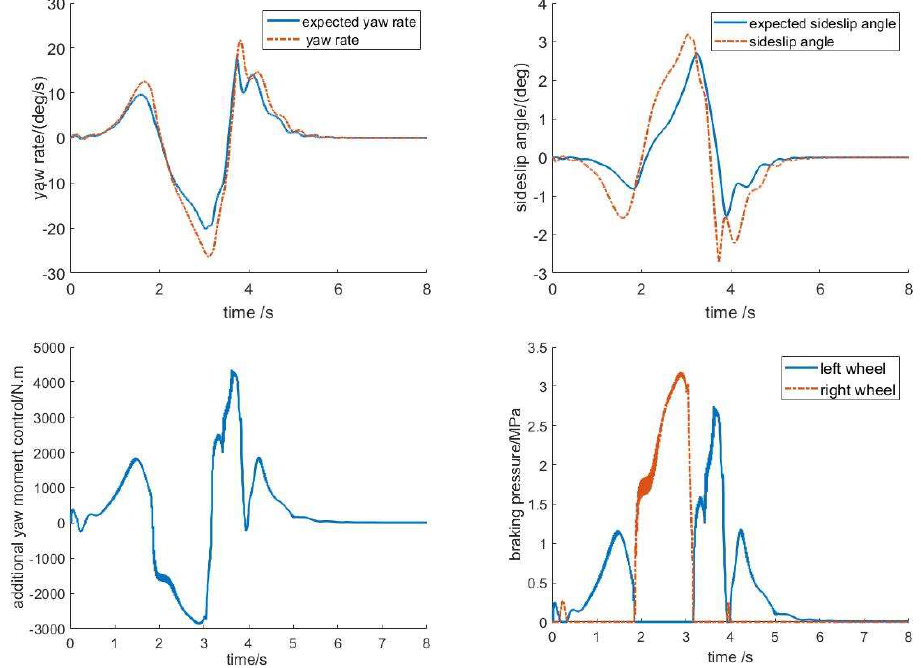
Figure 16. Simulation effect of